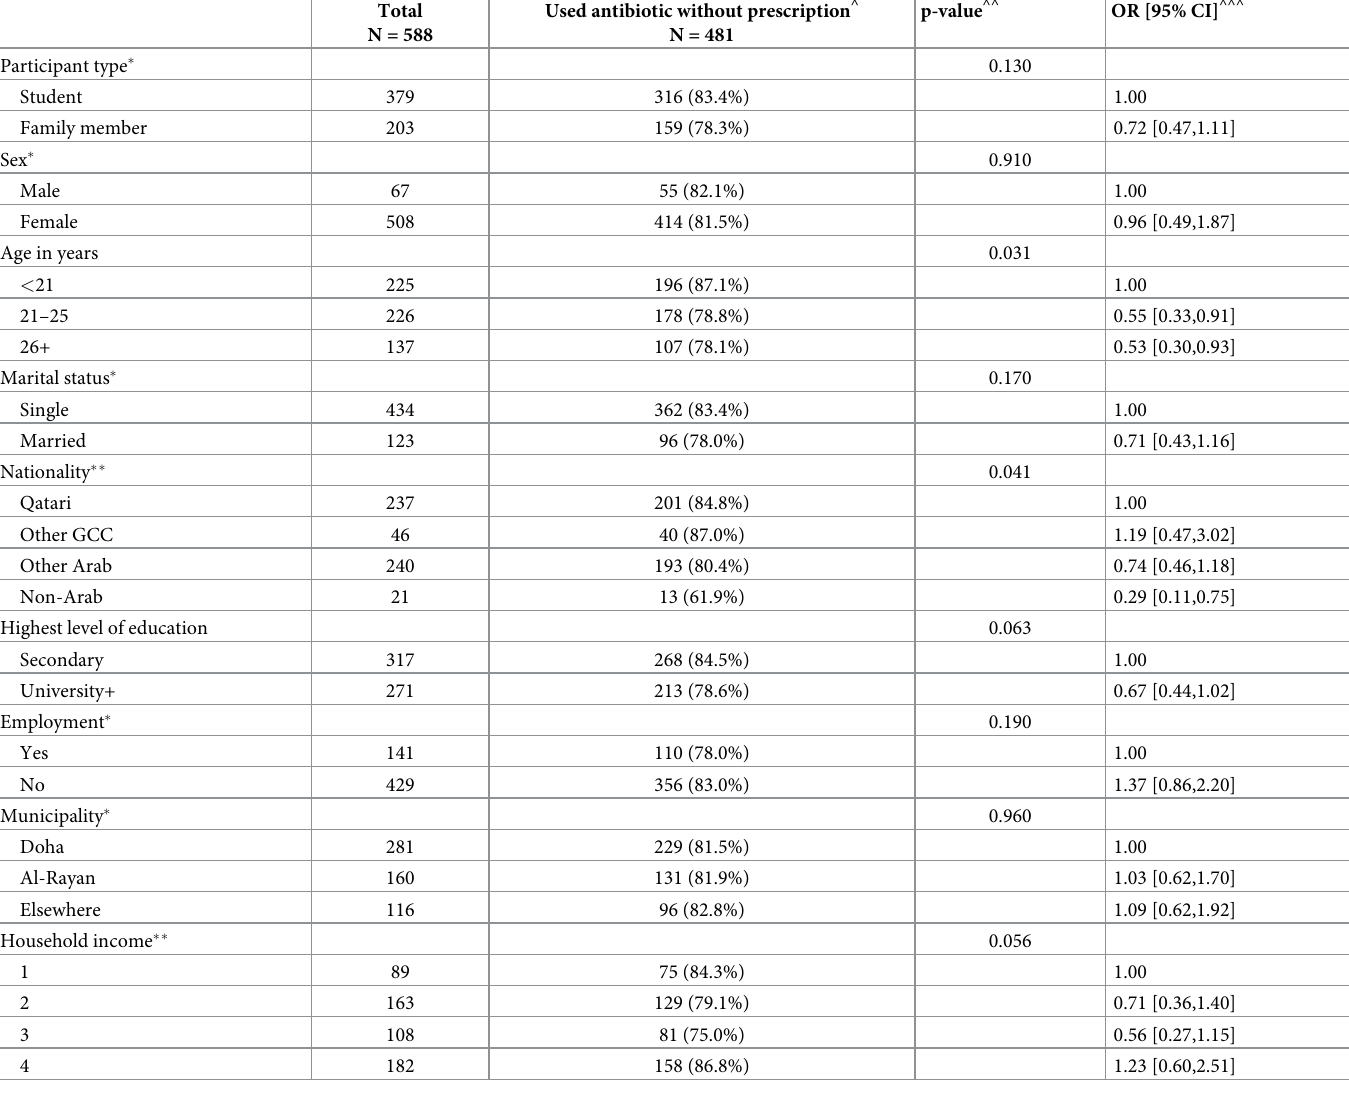
Table 3. Association between respondents’ characteristics and using antibiotics without